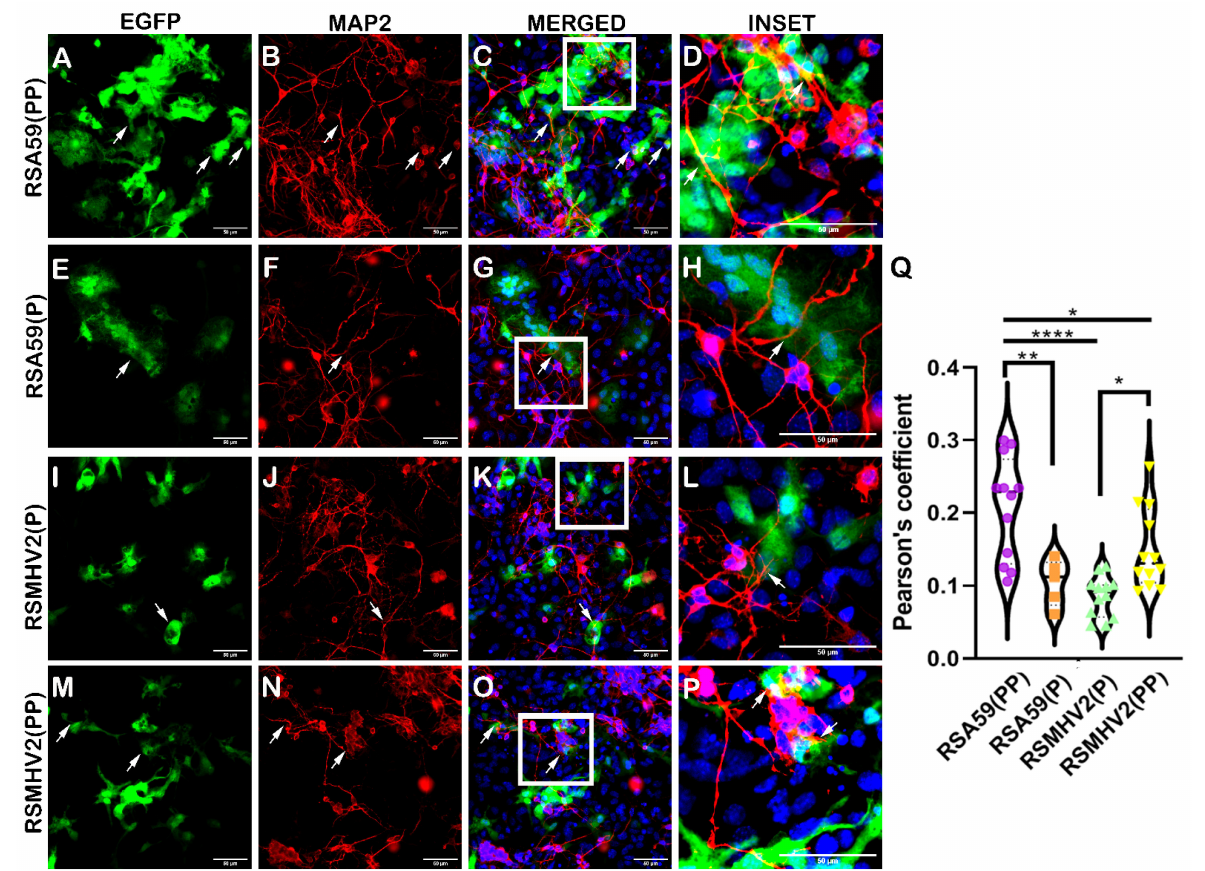
Figure 1. Infection of primary neuron enriched cultures with parental strains RSA59(PP), RSMHV2(P), one proline deleted RSA59(P), and one proline added RSMHV2(PP) mutants. Primary neuronal cultures isolated from day 0 C57BL/6 mice were infected with RSA59(PP) ( A – D ), RSA59(P) ( E – H ), RSMHV2(P) ( I – L ), and RSMHV2(PP) ( M – P ) at MOI 2. Cells were immunolabeled with MAP2 antibody at 24 h p.i. and counterstained with DAPI. Images presented show infected cells in the EGFP panels, and MAP2 panels indicate neurons in the culture. Merged panels show neurons with EGFP colocalization, with DAPI indicating the nucleus and arrowheads indicating infected cells. Panels ( D , H , L , P ) show colocalization in insets of higher magnification highlighted by a white rectangle area in the merged images. Quantified colocalization was presented in a violin diagram as the Pearson coefficient ( Q ). Experiments were performed three times in triplicate per strain (N = 9). The level of significance was taken at p < 0.05 following One-way ANOVA analysis. * p < 0.05, ** p < 0.001 and **** p <